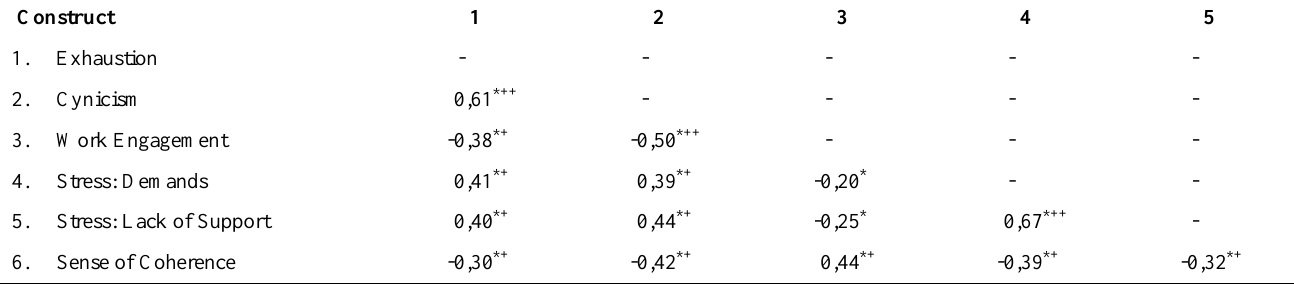
Table 2: Product-moment correlation coefficients between the MBI-GS, UWES, JSI and OLQ